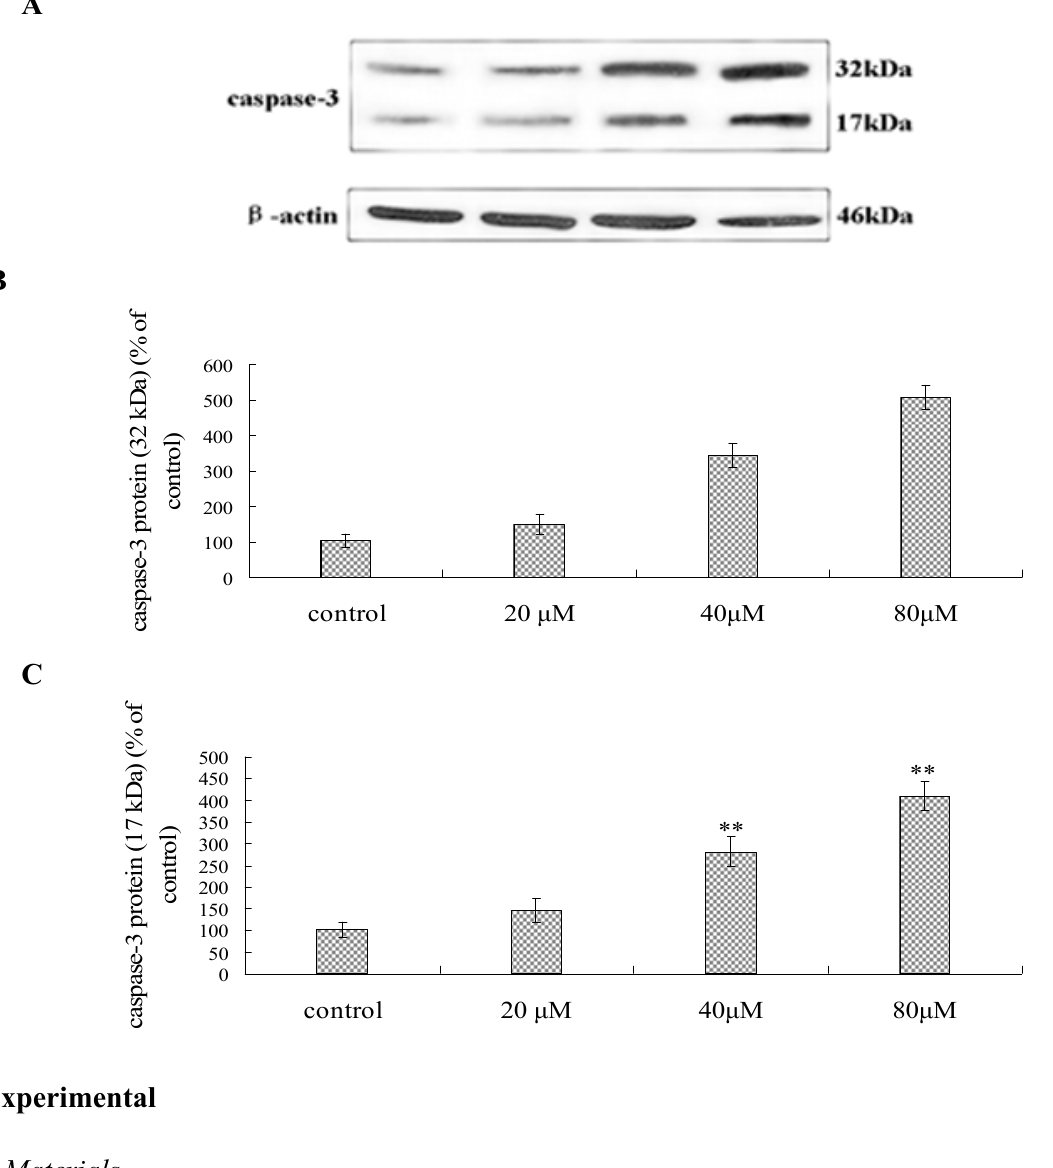
Figure 8. Bel-7402 cells were incubated with compound 1 at the concentrations of 20, 40 and 80 μ M for 48 h, respectively, then, the caspasse-3 (32 kDa) proteins and the cleavage product (17 kDa) of caspase-3 protein were measured by westblot method. ( A ) Effects of compound 1 on the expression levels of caspase-3 proteins. ( B ) The bar showed the caspasse-3 (32 kDa) proteins expression. ( C ) The bar displayed the cleavage product (17 kDa) of caspase-3 protein expression. ** p < 0.01 as compared to